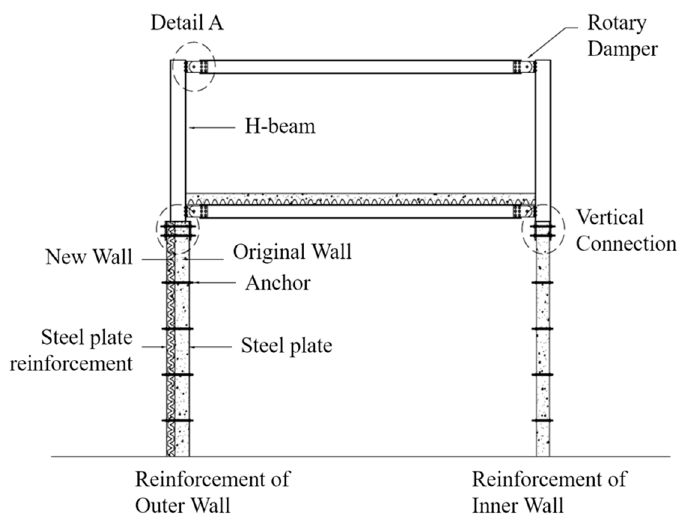
Figure 3. Story-increased module with beam-end rotational damper.